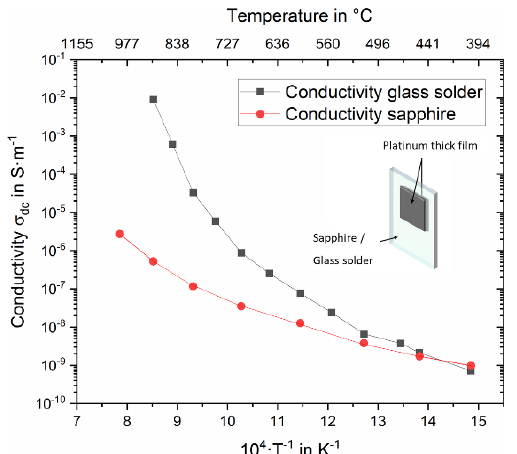
Figure 22. Measured conductivity using the plate structure with sapphire and glass solder insulating material as a function of tem-